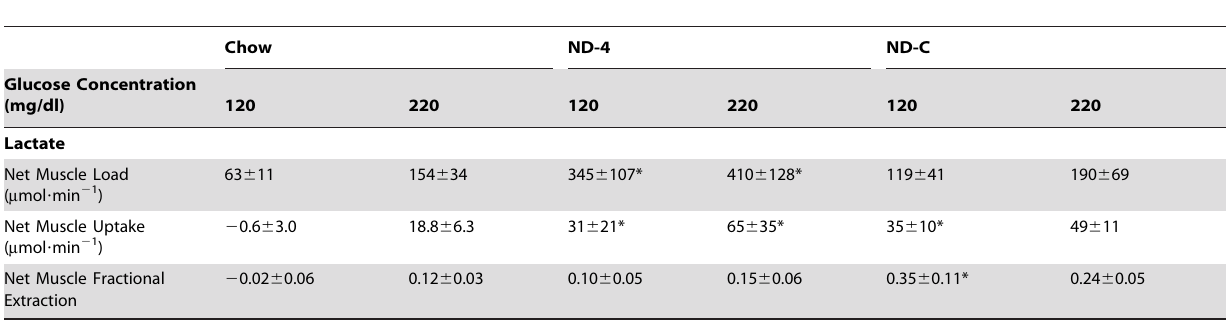
Table 3. Muscle lactate load, uptake and fractional extraction in chronically catheterized conscious insulin-treated depancreatized dogs on a chow diet or fed an isocaloric nutritional support as a constant infusion (ND-C) or once a day for 4 days (ND-4).